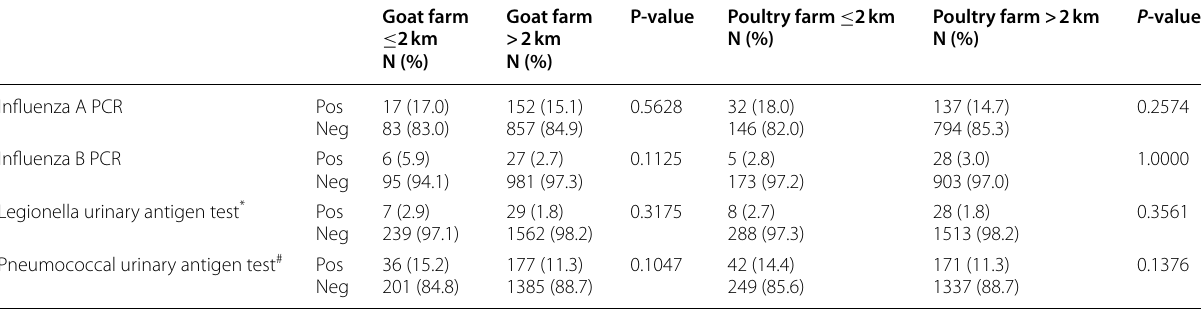
Table 2 Laboratory results of PCR and urinary antigen tests of pneumonia patients, grouped by livestock farm